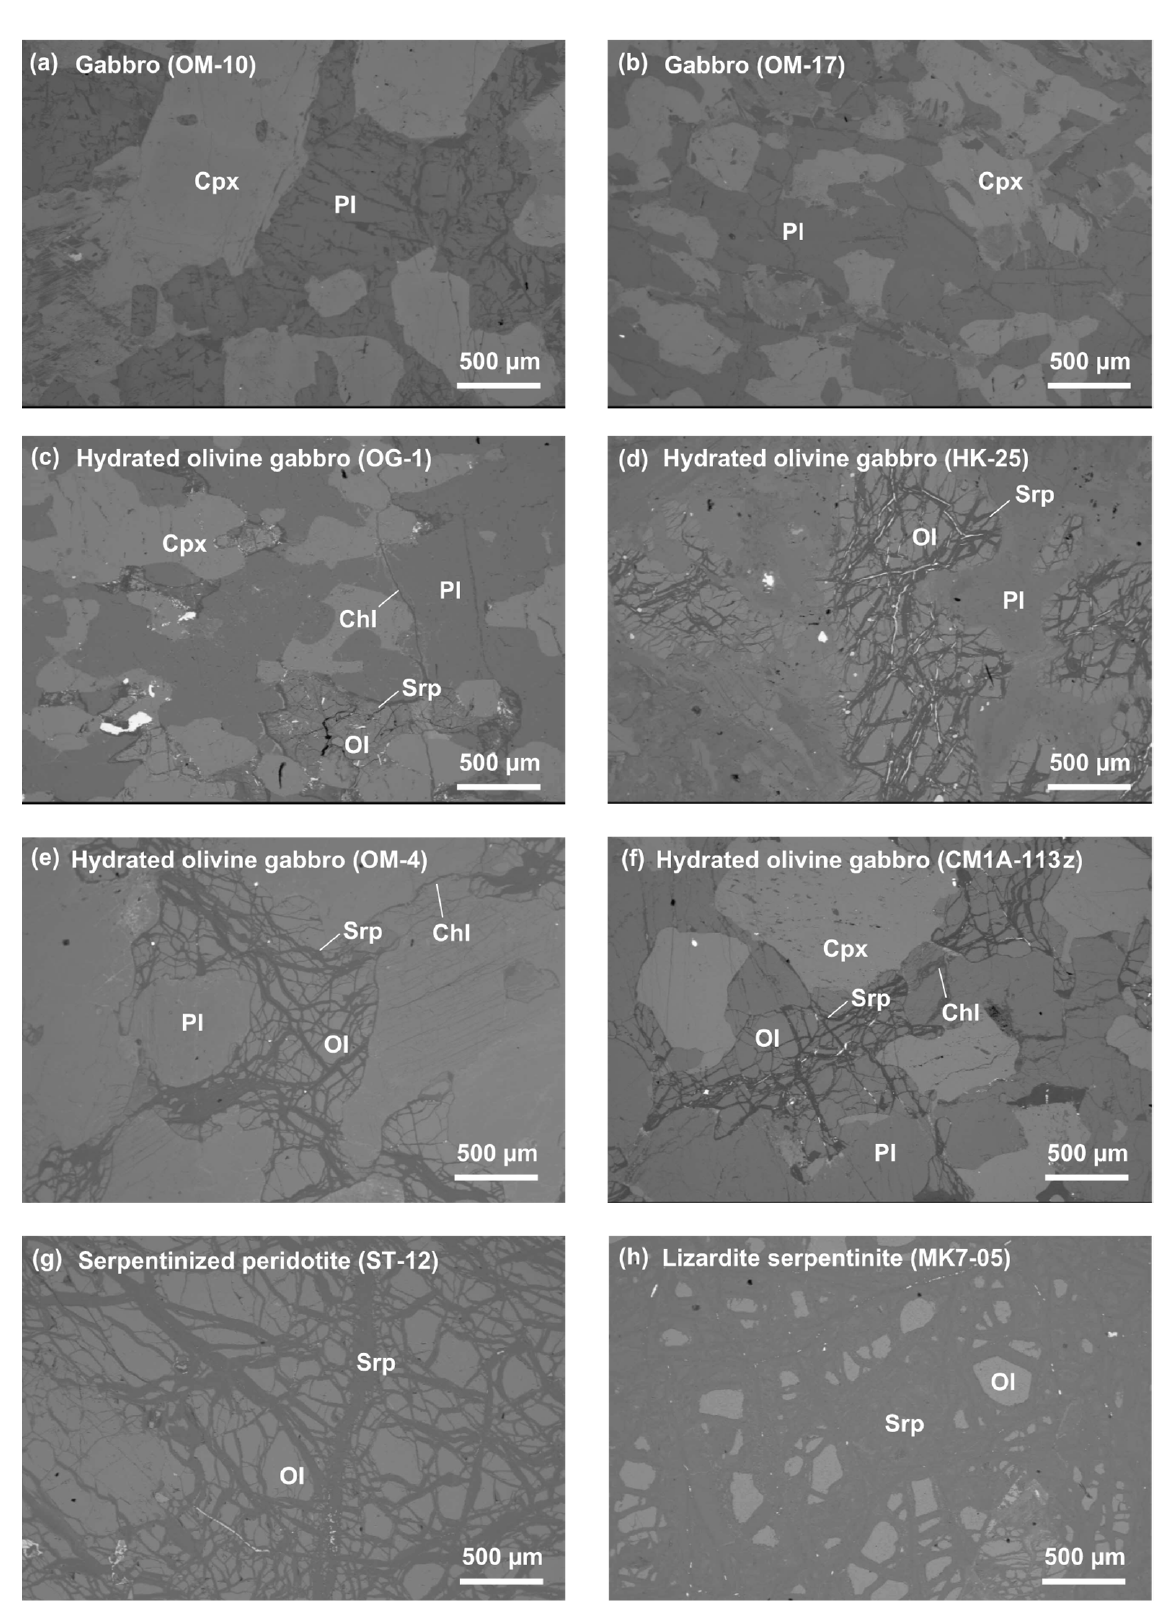
Figure 1. SEM images of each experimental sample: gabbro ( a , b ), hydrated olivine gabbro ( c – f ), serpentinized peridotite ( g ), and lizardite serpentinite ( h ). Abbreviations for minerals: Cpx, Clinopyroxene; Pl, Plagioclase; Ol, Olivine; Srp, Serpentine; Chl, Chlorite.